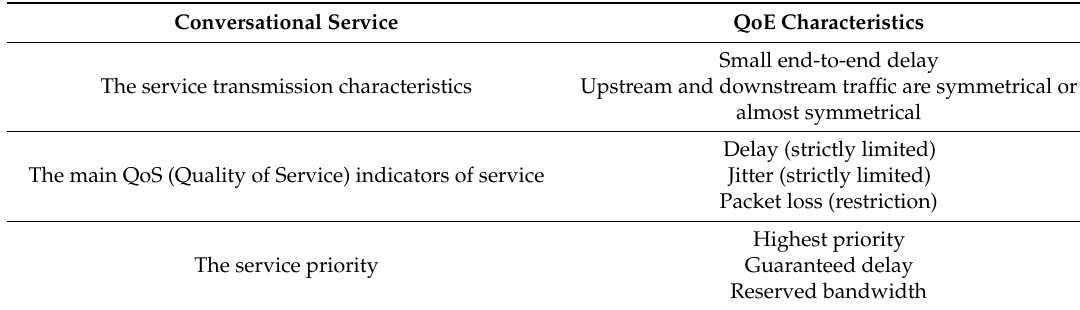
Table 1. The QoE (Quality of Experience) characteristics of conversational